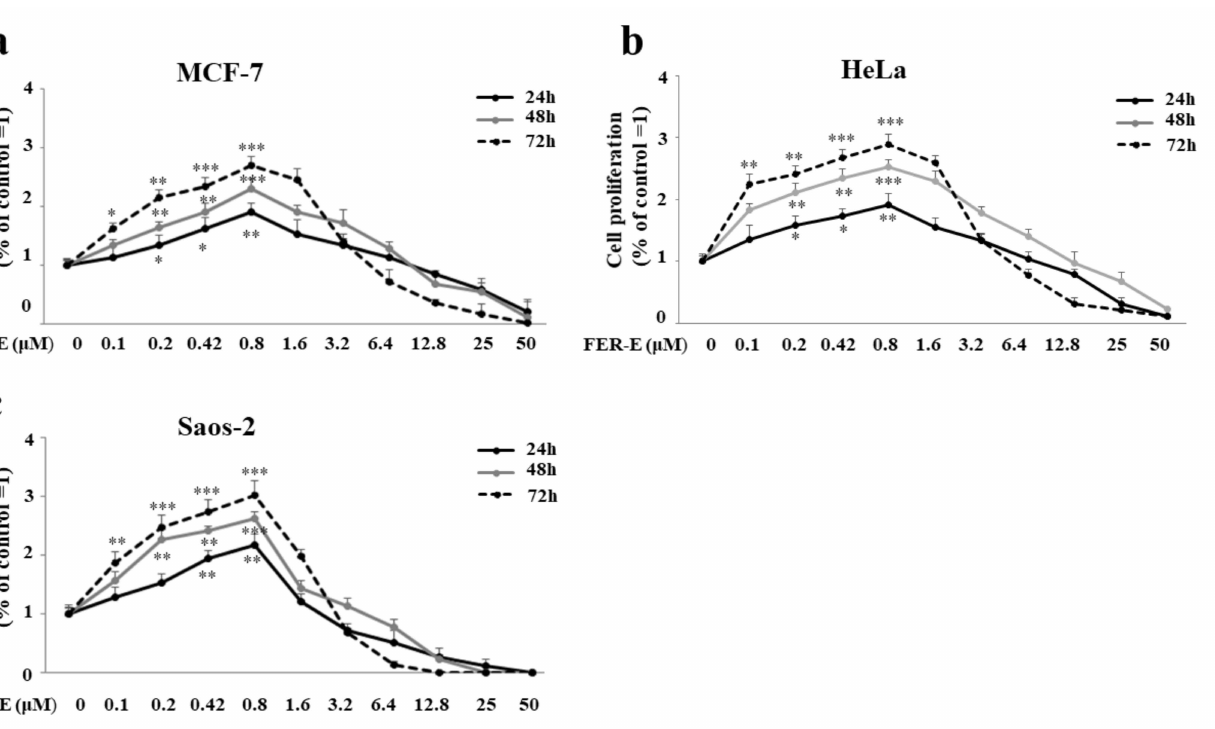
Figure 4. Dose-dependent effect induced by FER-E treatment. Dose–response curves were con- structed by treating the cell lines considered with increasing concentrations of FER-E. Panels ( a – c ) refer to viability data induced in MCF-7, HeLa e Saos-2, respectively. Three independent experiments were carried out and the values are expressed as the mean ± standard deviation (sd). * denotes p < 0.05 versus the control; ** denotes p < 0.01 versus the control; *** denotes p < 0.001 versus the control. Analysis of Variance (ANOVA) was followed by a Tukey–Kramer comparison test. Each treatment was carried out in